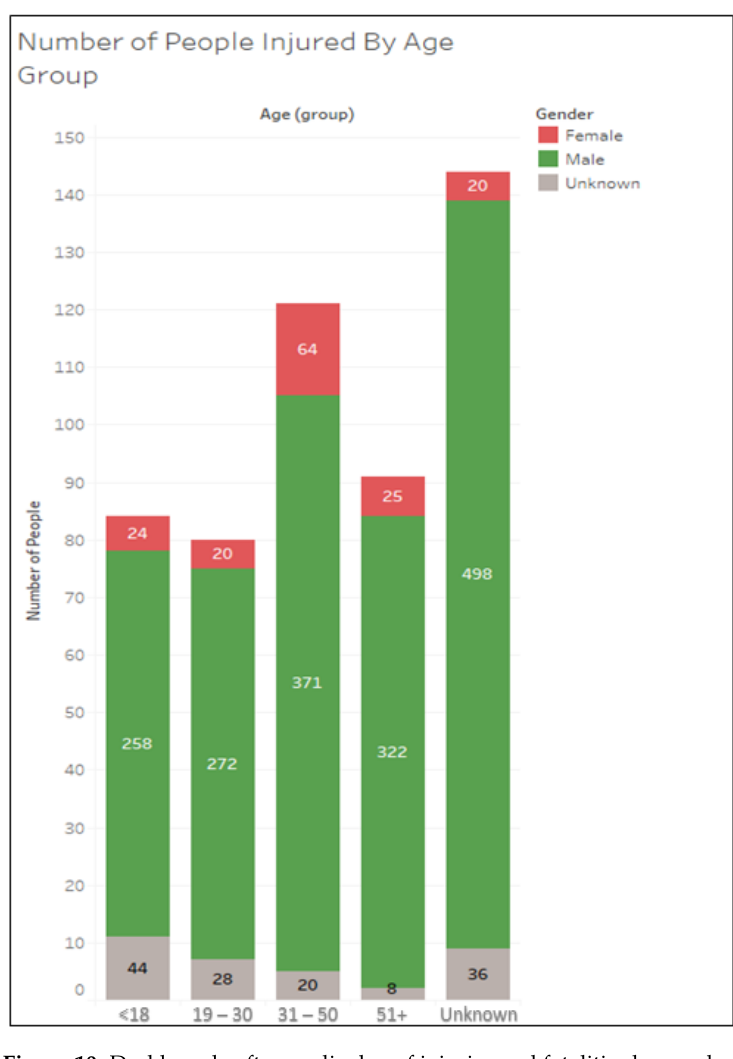
Figure 10. Dashboard software display of injuries and fatalities by gender.